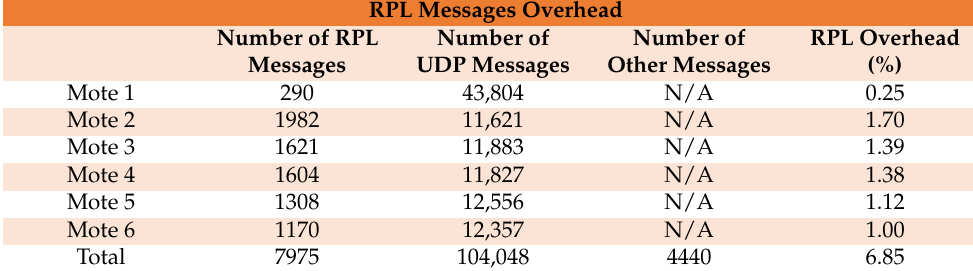
Table 3. RPL messages overhead of the IoT/IIoT network in the benign scenario.